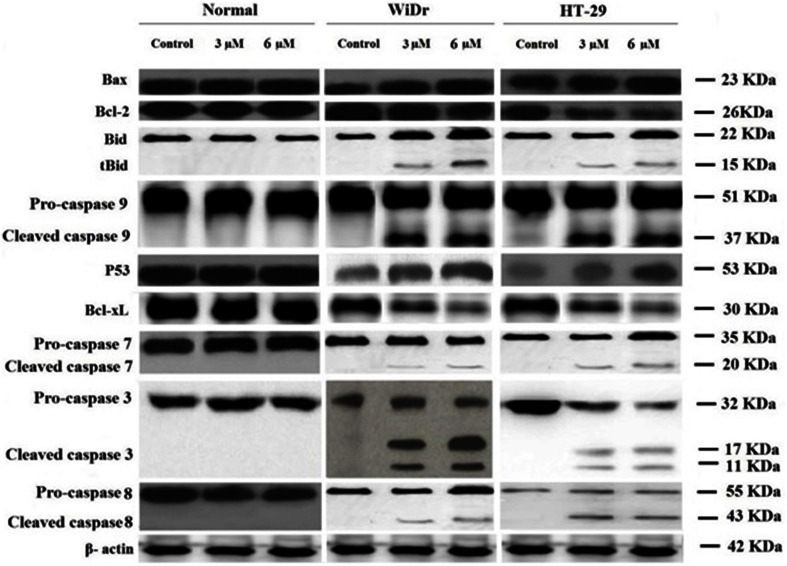
Western blot analysis of cancer and normal cell lines. Cells were treated with 3.0 and 6.0 μM of NTC for 24 h. Proteins were transferred to a membrane and followed by probing with antibodies. Normalization of band densities of treated samples were accomplished based on the control. The results represent significant increase in the expression level of caspase 3, 7, 8, 9, p53, Bax and conversion of Bid to its truncated, whereas decrease in Bcl-2 and Bcl-xL level.